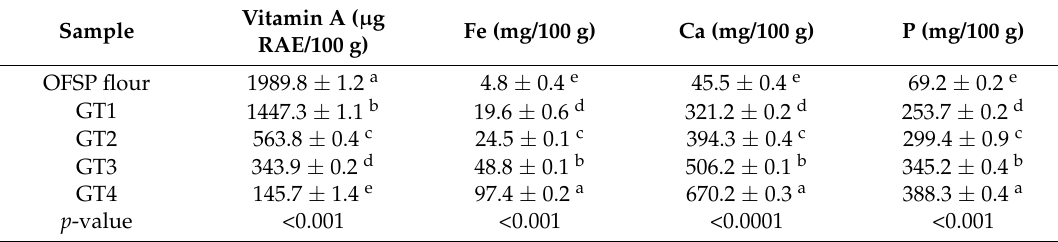
Table 3. Mineral and vitamin A ( µ g RAE) content of orange fleshed sweet potato-based composite flours on dry weight basis.